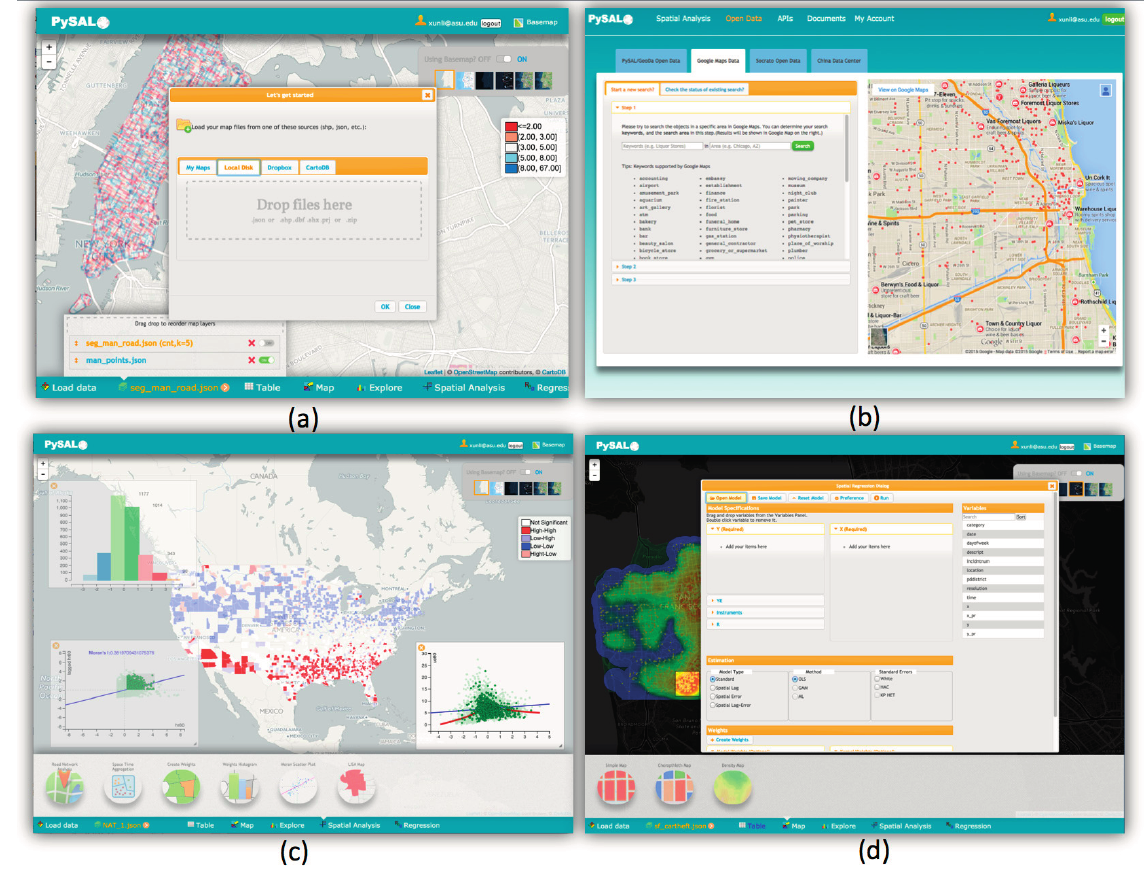
Figure 10. PySAL-Cloud: A prototype of a cloud-based spatial analysis